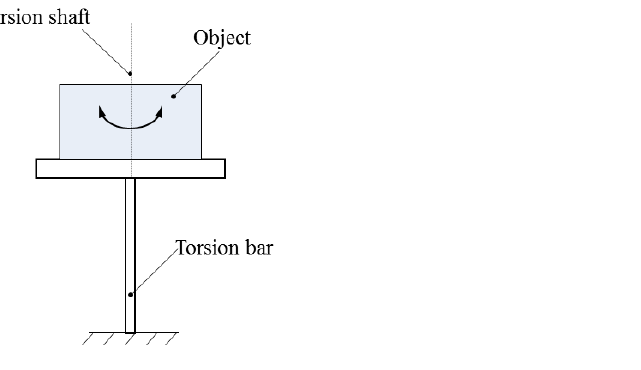
Figure 3. Schematic diagram of measuring MOI by torsional pendulum method.